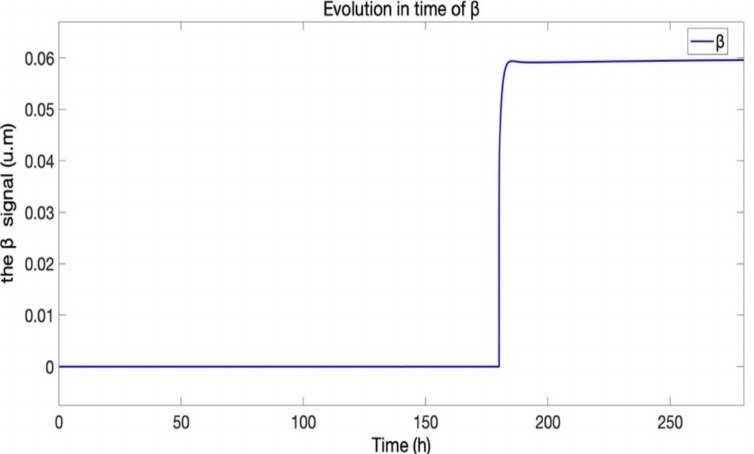
Figure 18. Evolution in time of control effort ( ∆ β ) if the variation of β = 0.91 to β = 0.97 at t = 180 ( h )